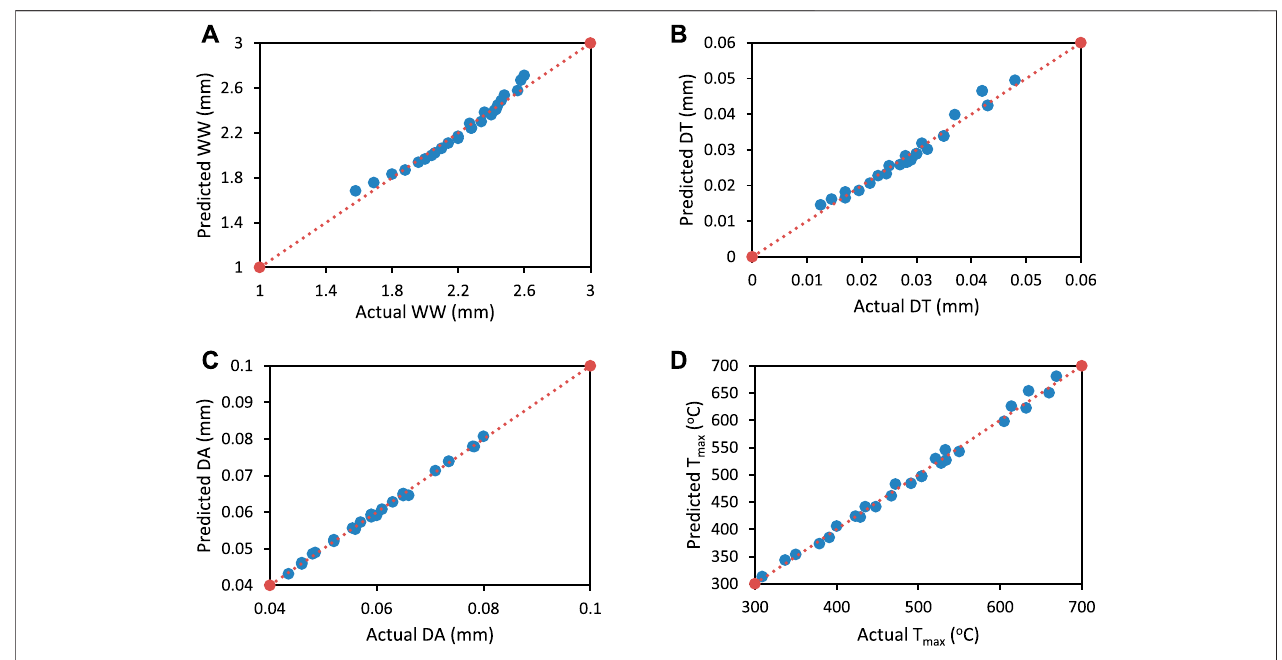
FIGURE 7 | Plot of actual vs predicted response of (A) WW (mm), (B) DT (mm), and (C) DA (mm) (D) T max ( o C), results.